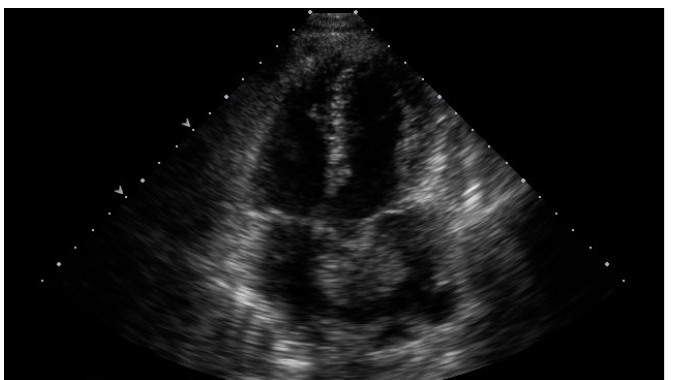
Figure . Echocardiography of patient diagnosed with left atrial